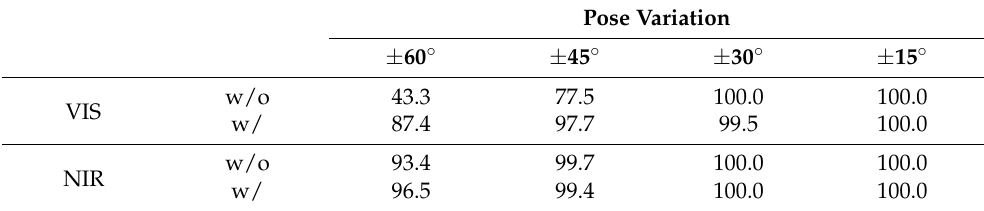
Table 4. Results (in %) of rank-1 with and without FNM on TUFTS-Pose database with quantification of pose variation, using the Light CNN-29 and cosine similarity